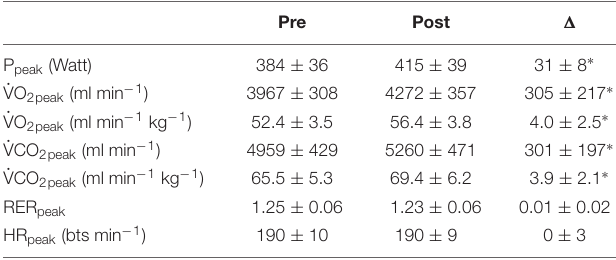
TABLE 1 | Overview of the cardiorespiratory responses to incremental ramp exercise pre- and post-training intervention.